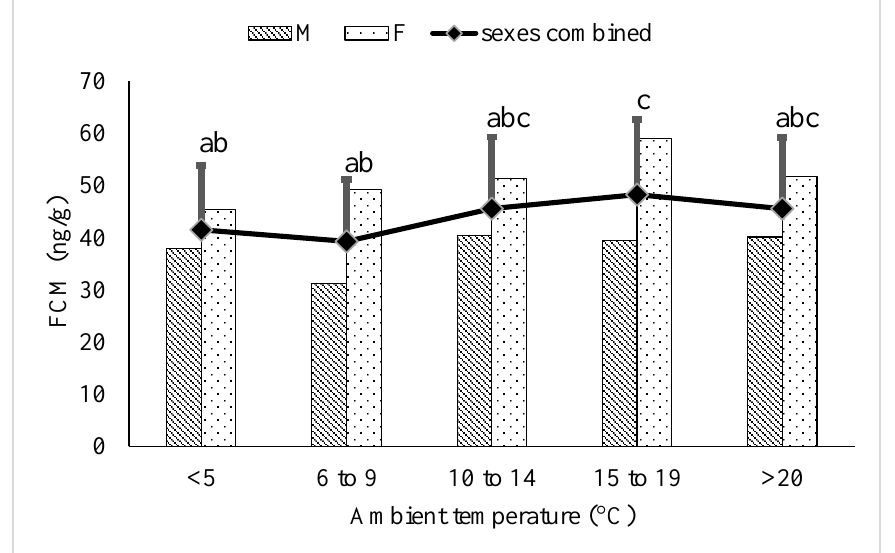
Figure 1. Back-transformed LSMeans ± SEM for fecal cortisol metabolite (FCM) concentrations (ng/g dry feces) within different ambient temperature categories for juvenile (≤5 years) polar bears (N samples = 1613). Different subscripts represent differences between temperature categories ( p < 0.05). Columns represent sex-specific back-transformed LSMeans for each temperature category.